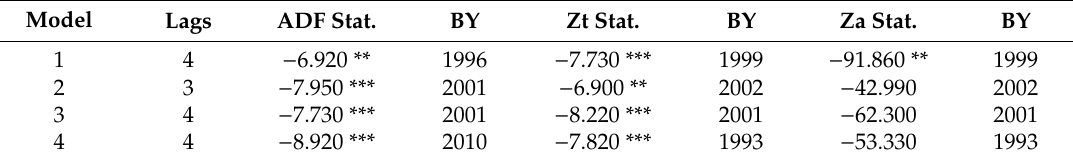
Table 4. The Gregory-Hansen Cointegration test results. Model